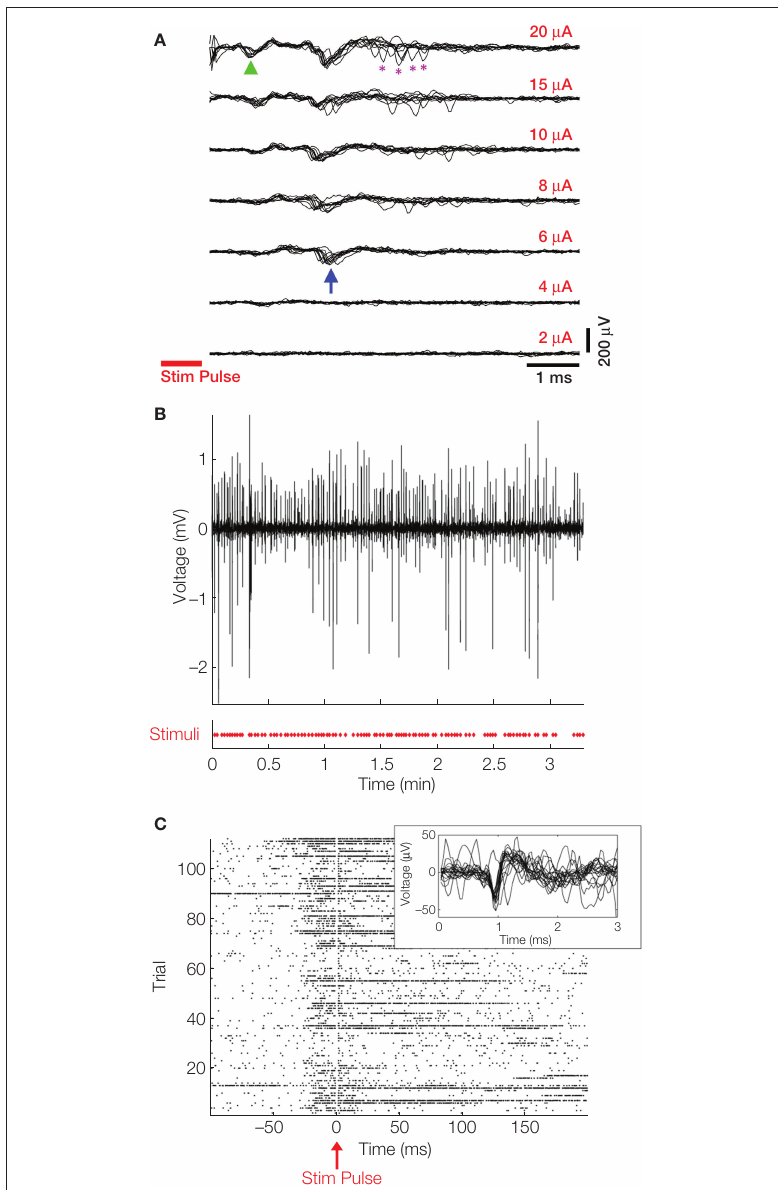
Figure 3 | Closed-loop stimulation responses. (A) Biphasic current-controlled stimuli (cathodic, negative phase first; 400 m s per phase) were delivered to an electrode in CA1 of the hippocampus, and responses were recorded as seen here in CA3. Ten trials of every stimulus amplitude are overlaid in each panel. Stimulus duration is indicated by the red bar. The first action potentials appear at a certain stimulus threshold ( ≥ 6 m A, blue arrow), with the latency decreasing as current is increased (green arrowhead). Additional, less consistent action potentials are recruited at high stimulation intensities (purple asterisks). All traces were digitally filtered with the SALPA algorithm (Wagenaar and Potter, 2002). Stimuli were delivered at 1 Hz and in random order (to guard against neural adaptation). (B) The LFP of an electrode in CA3 was monitored for interictal spikes (IISs) and a single 10 m A biphasic current-controlled pulse was delivered to one microelectrode upon IIS detection (red X’s in bottom panel). The displayed LFP trace (top panel) is from one electrode of an array implanted in CA1. The large amplitude is typical of LFPs during IISs and seizures. (C) A raster plot of action potentials recorded from all of the 16 electrodes during many IISs is shown, time-locked to the stimulus pulse. Action potentials are evoked by the stimulus at low latency following each pulse. The inset shows sample evoked AP waveforms recorded from one of the 16 electrodes during the experiment. This experiment is further characterized in Rolston et al.